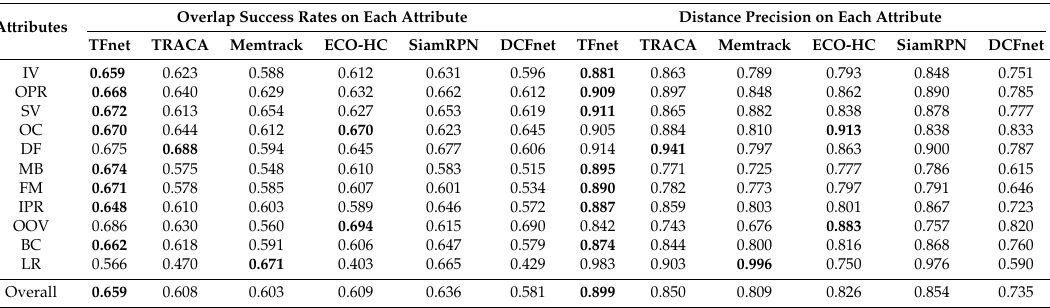
Table 1. Individual attributes comparisons of the proposed method with five state-of-the-art real-time trackers on the OTB2013.